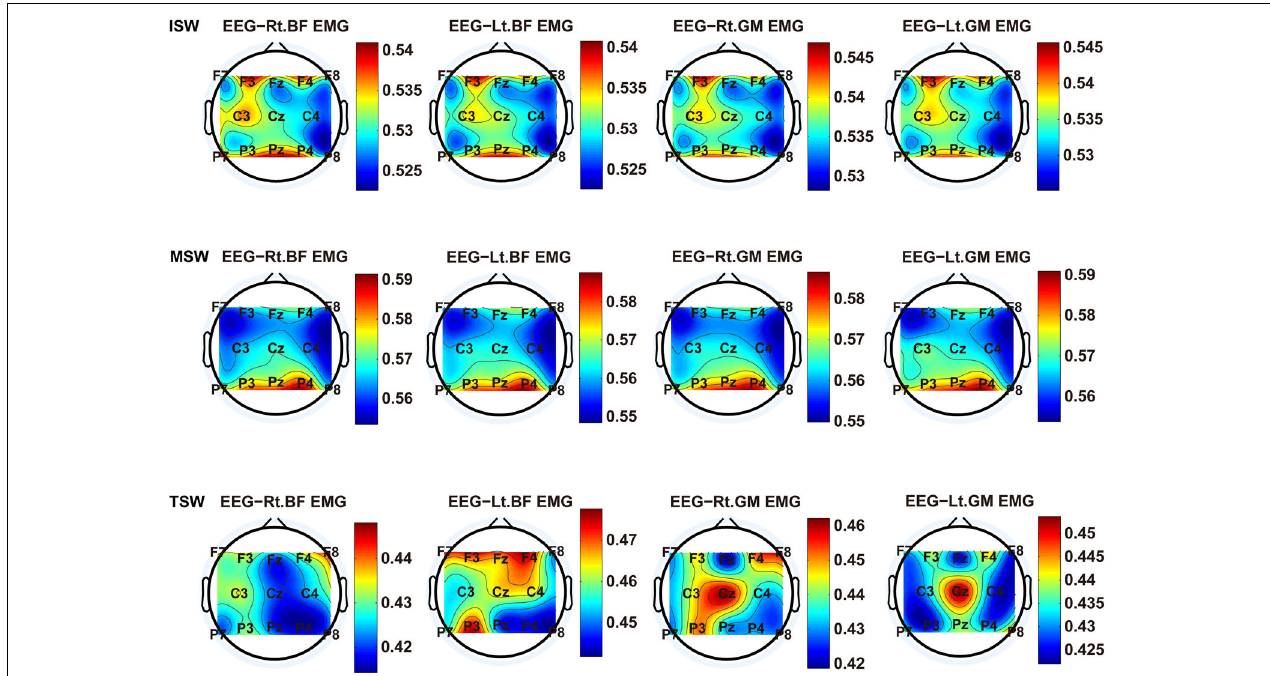
FIGURE 8 | TFCMI topography between EEG (beta band) and sEMG (BF and GM) of the stance phase (ISW, MSW, and TSW).